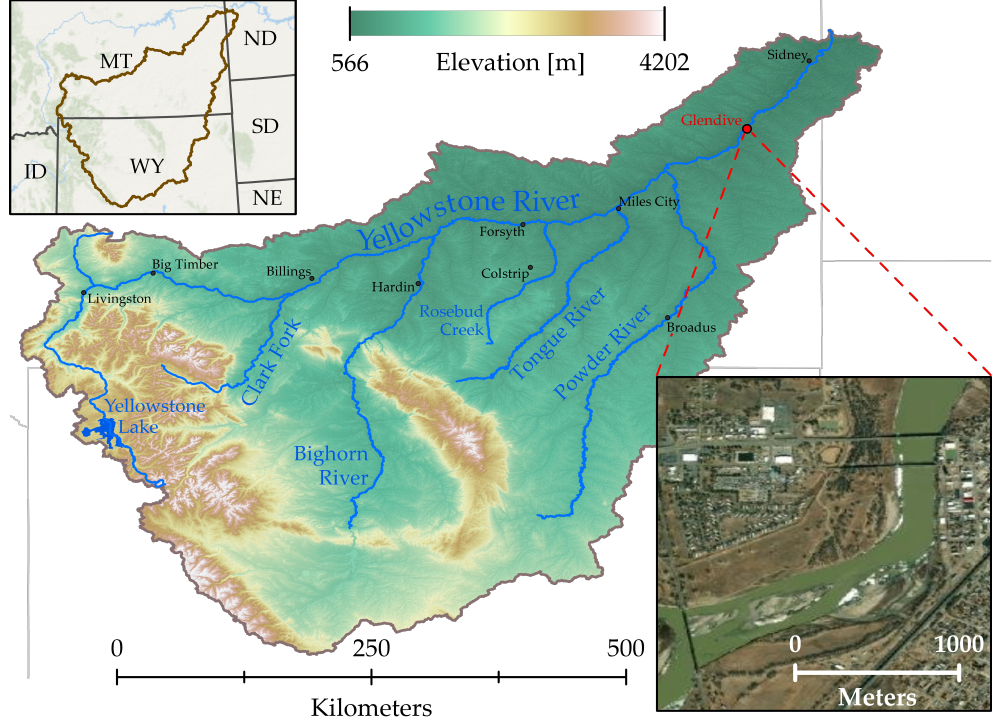
Figure 2. Yellowstone River watershed. The Yellowstone River drains approximately 100,000 km 2 of land area in Montana, Wyoming, and North Dakota, USA, into the upper Missouri River via the Yellowstone River and its major tributaries, the Powder, Tongue, Bighorn, and Clark Fork Rivers, and Rosebud Creek. Our study site is located on Yellowstone in Glendive, Montana (bottom right panel). Satellite imagery ©Maxar